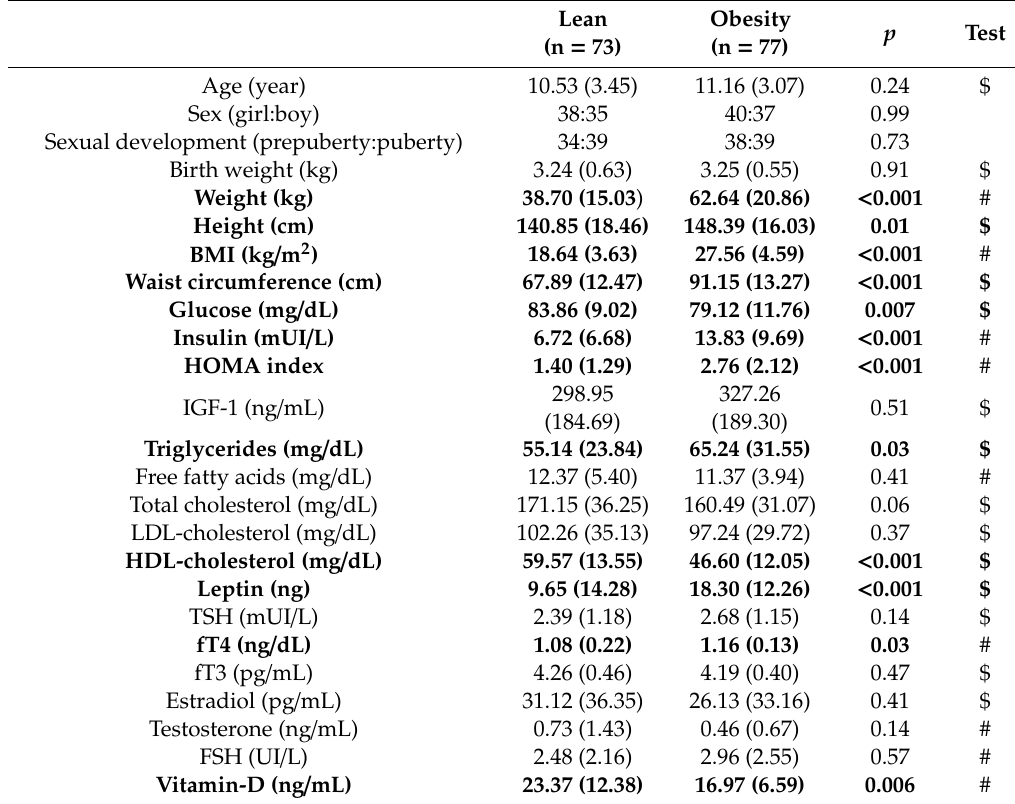
Table 1. Anthropometric and biochemical characteristics of the cross-sectional study population.